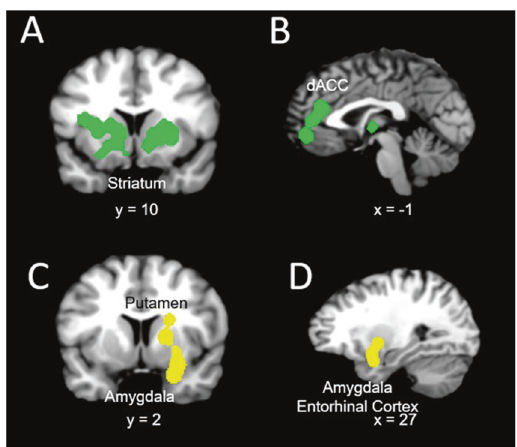
Fig. 2 Concordant activation across SUD and BA. A , B : regions concordant across studies for SUD (in green) and C , D : regions concordant across studies for BA (in